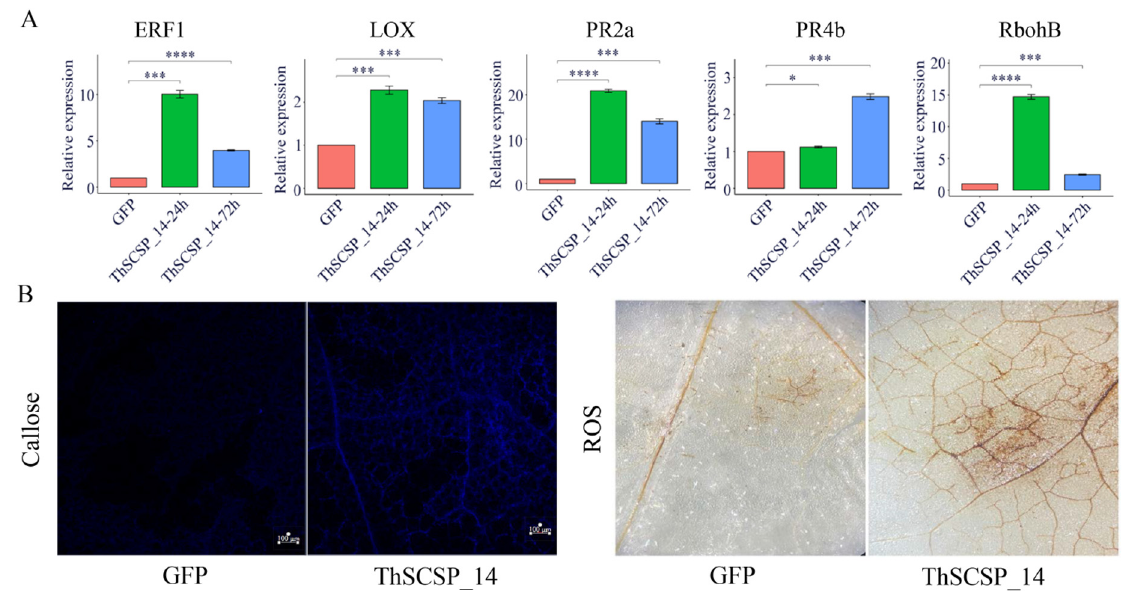
Figure 7. ThSCSP_14 triggers immunity responses in Nicotiana benthamiana . ( A ) Expression levels of genes related to plant immunity in N. benthamiana leaves were detected at 24 and 72 h post-inoculation. Error bars are the standard deviation (SD) of four independent replicates (* p < 0.05; *** p < 0.001; **** p < 0.0001). ( B ) Accumulation of reactive oxygen species (ROS) and deposition of callose in N. benthamiana . Bars = 100 μ m. These experiments were replicated three times, using six leaves per biological replicate.